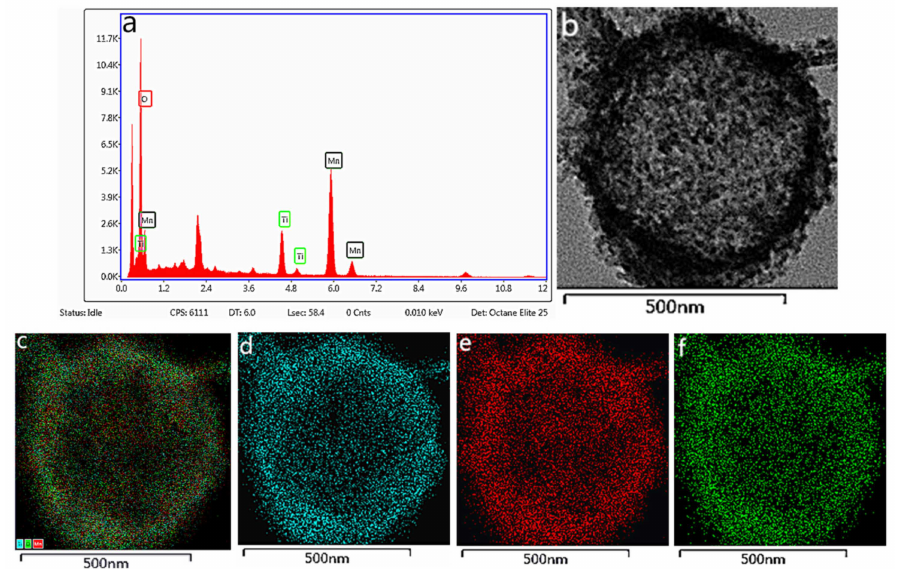
Figure 2. EDX spectrum of areas ( a ), SEM ( b ), STEM image ( c ) and EDX mapping of HTM ( d ) Ti, ( e ) Mn, and ( f )